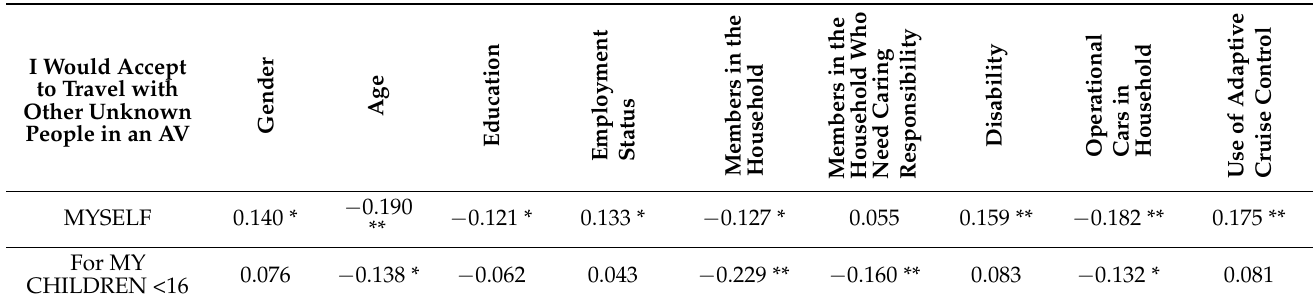
Table 8. Spearman correlation between socio-economic characteristics of the sample and potential use of AVs by the children under 16 (Source: Authors’ survey data).